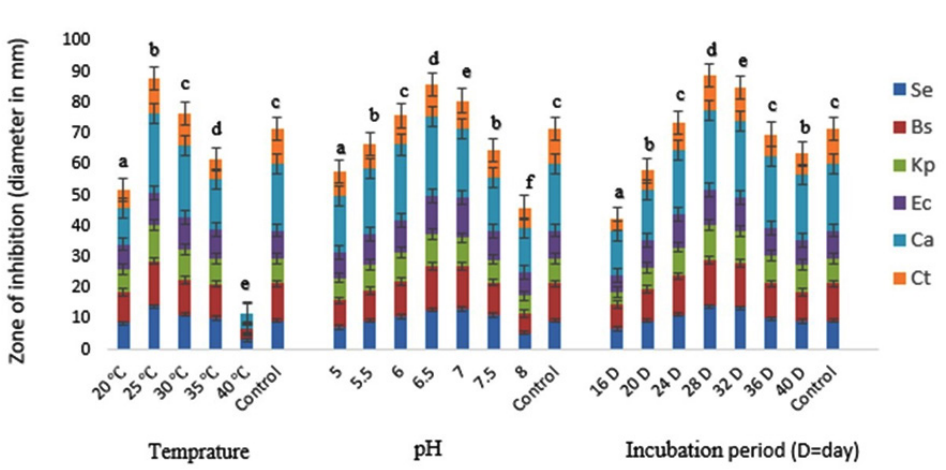
Fig. 3. Effect of different temperature, pH and incubation period on the bioactive metabolite production by G. pallida (KU693285) against test microbes. Se= S. epidermidis, Bs =B. subtilis, Kp = K. pneumoniae, Ec =E. coli, Ca =C. albicans, Ct = C. tropicalis. Vertical bars represent standard deviation (±SD, n=3). Means with different letters within an assay were significantly different (p <